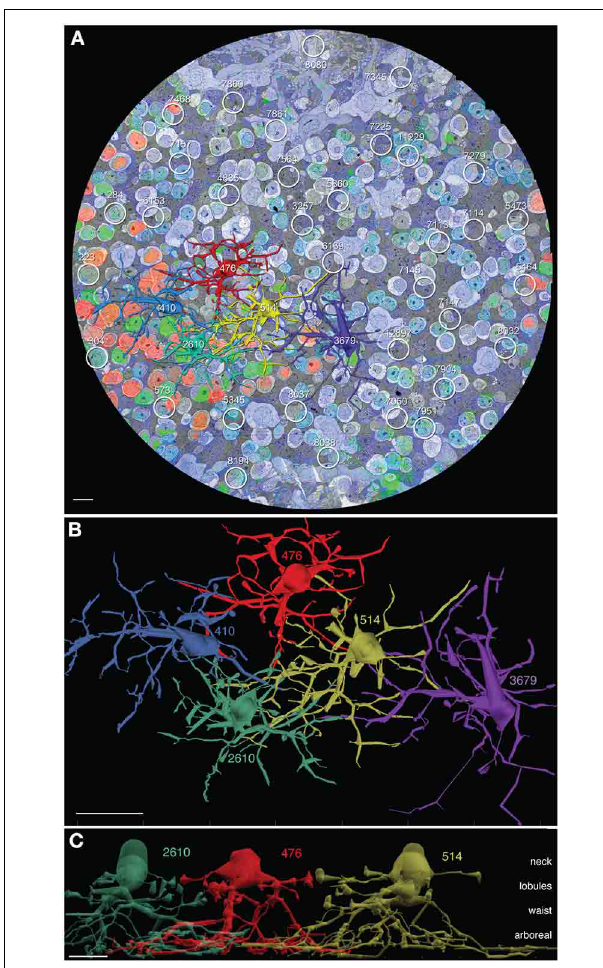
FIGURE 2 | AII cells in connectome RC1. (A) Slice z001 with 5 channel molecular overlay (see Anderson et al., 2011b), 5 rendered AII cells (410 blue, 476 red, 514 gold, 2610 green, 3679 purple) and 34 other AII loci indicated by circles. (B) Top view (XY plane) of VikingPlot rendered AII amacrine cells. (C) Side view of AII amacrine cells 2610, 476, and 514 laterally displaced to reveal the neck, lobule, waist, and arboreal zones. Scales (A,C) 10 μ m; (B) 20 μ m.